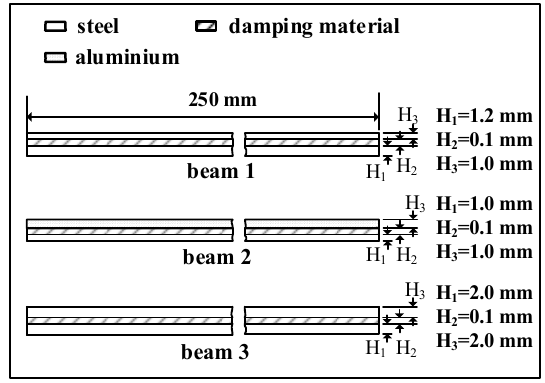
Figure 2. Three sandwich beams with one identical damping layer.